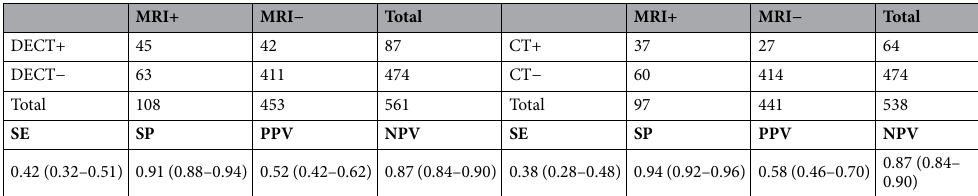
Table 3. Contingency table analysis of presence of discoid or mixed stenosis for DECT or CT with MRI as standard of reference. Data are given with 95% confidence intervals. SE sensitivity, SP specificity, PPV positive predictive value, NPV negative predictive value, MRI magnetic resonance imaging, CT computed tomography, DECT dual-energy computed tomography, + discoid or mixed stenosis, − no stenosis or osseous stenosis.